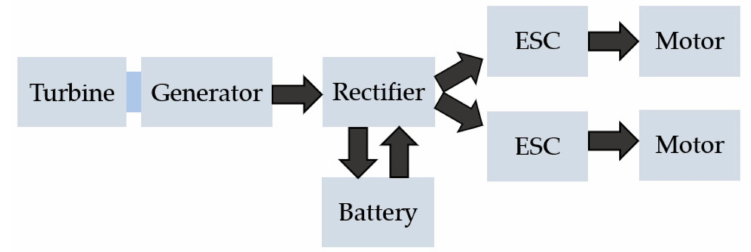
Figure 3. Final main power system diagram.